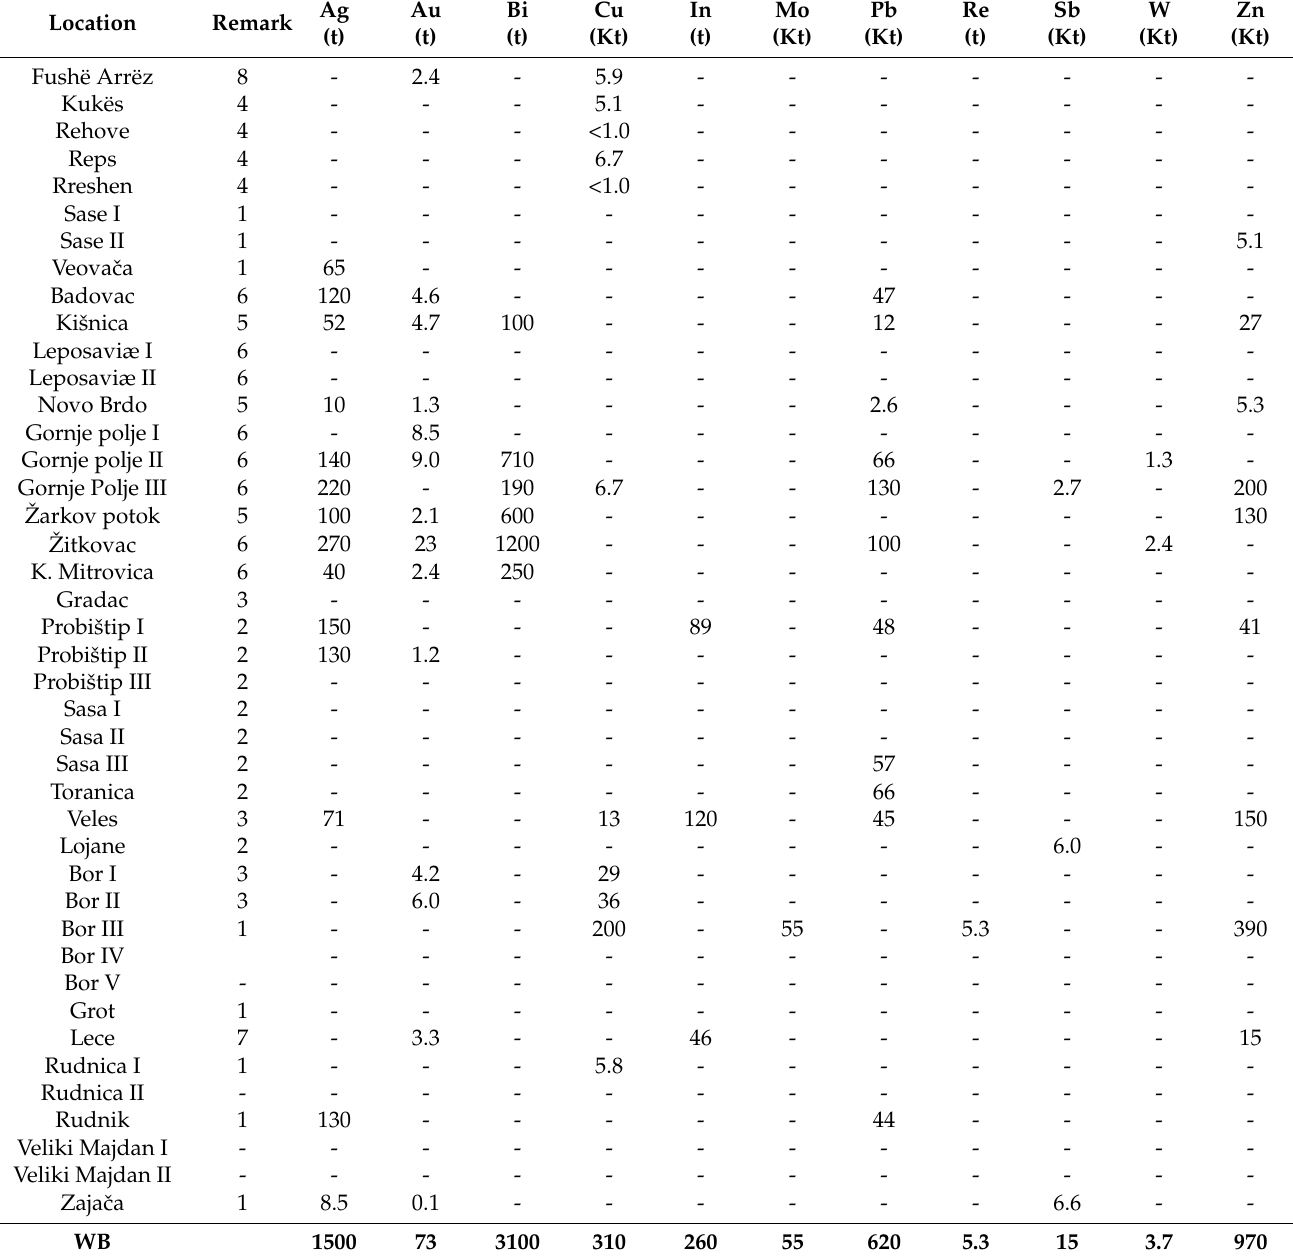
Table 3. Basic data of potentially prospective SRM